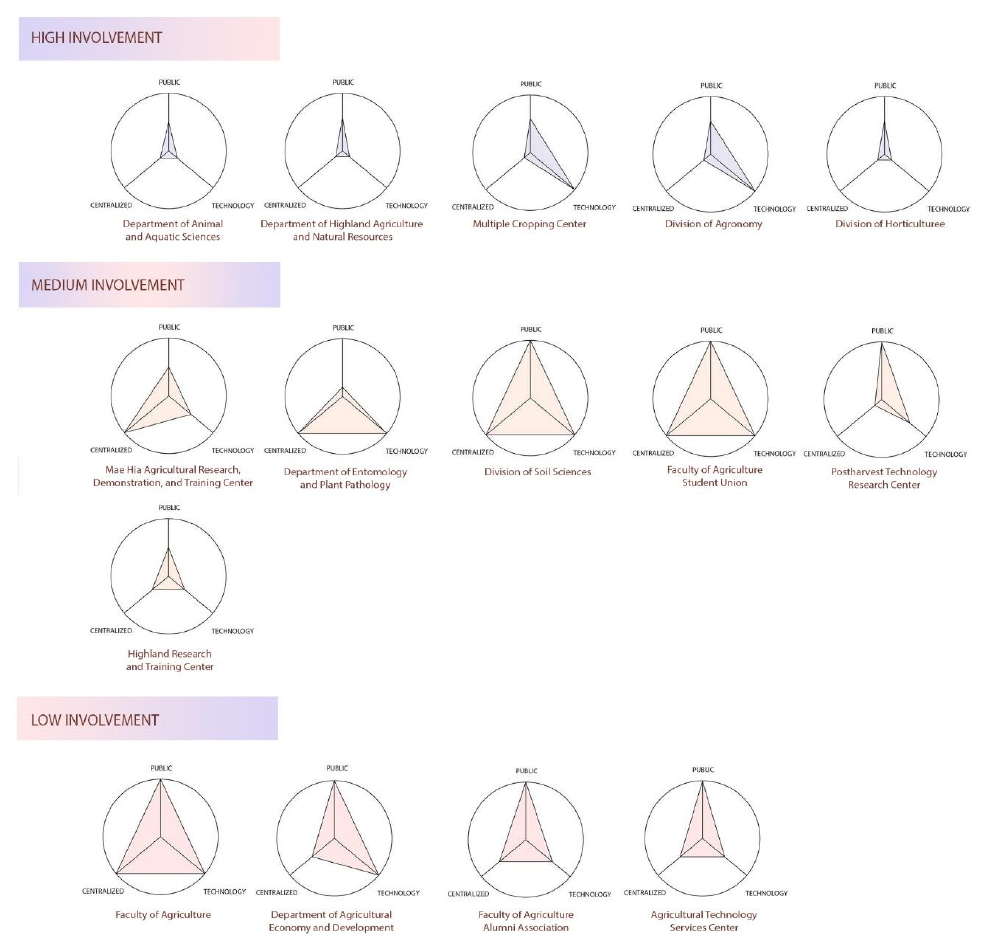
Figure 5. Involvement of the organizations and their opinions about three main themes of changes.